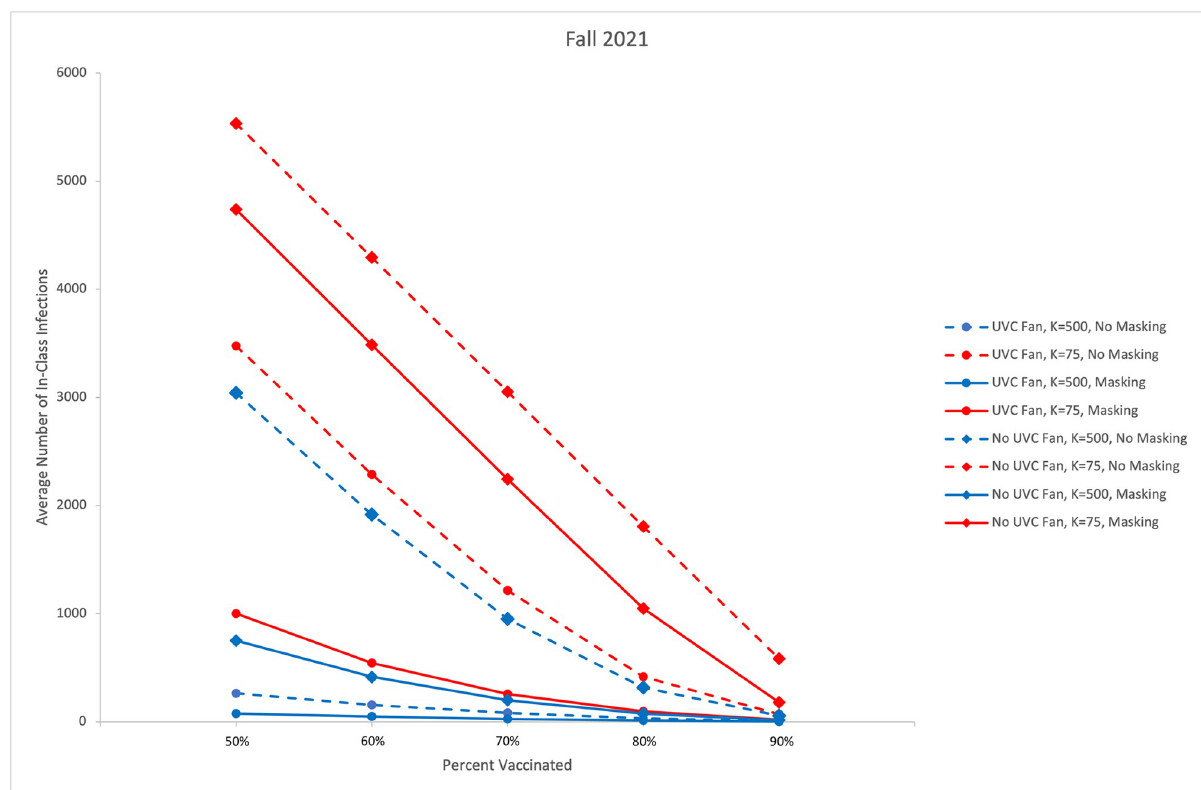
Fig 5. Average infections by immunity rate and